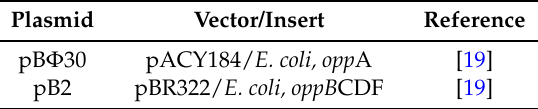
Table 7. Plasmids used in this